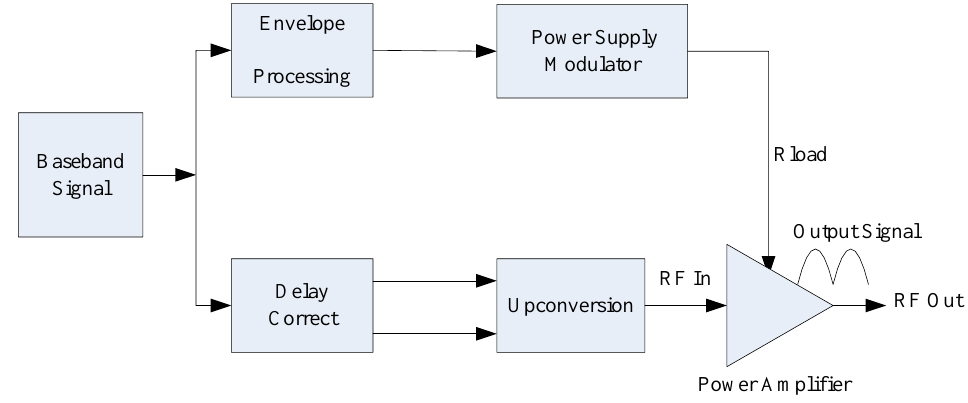
Figure 1. Basic block diagram of envelope tracking.